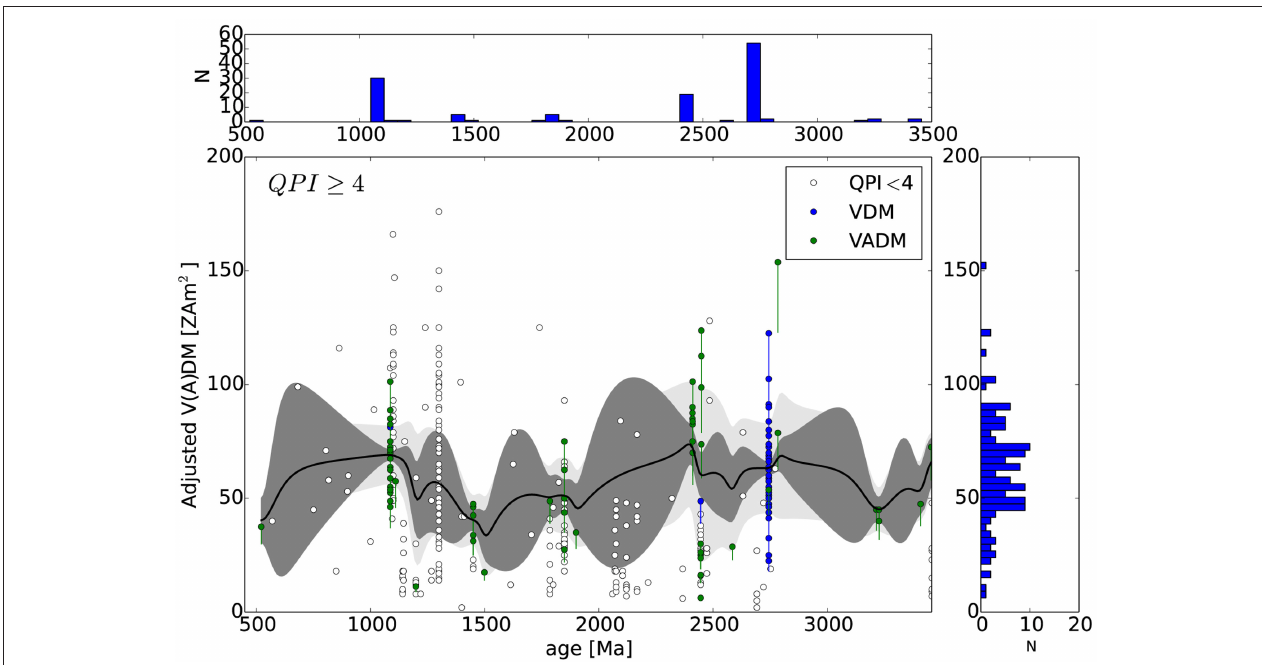
FIGURE 14 | Adjusted paleointensity (VDM and VADM) from the PINT database with inverse-distance squared smoothing with τ IDS = 30 Myr (solid line) applied to adjusted data with QPI ≥ 4 (filled circles). Open circles have QPI < 4. VDM’s and VADM’s are both divided by 0.8 as in Figure 13 . Vertical lines connect adjusted to original values. (Right) histogram of VDM and VADM. (Top) histogram of